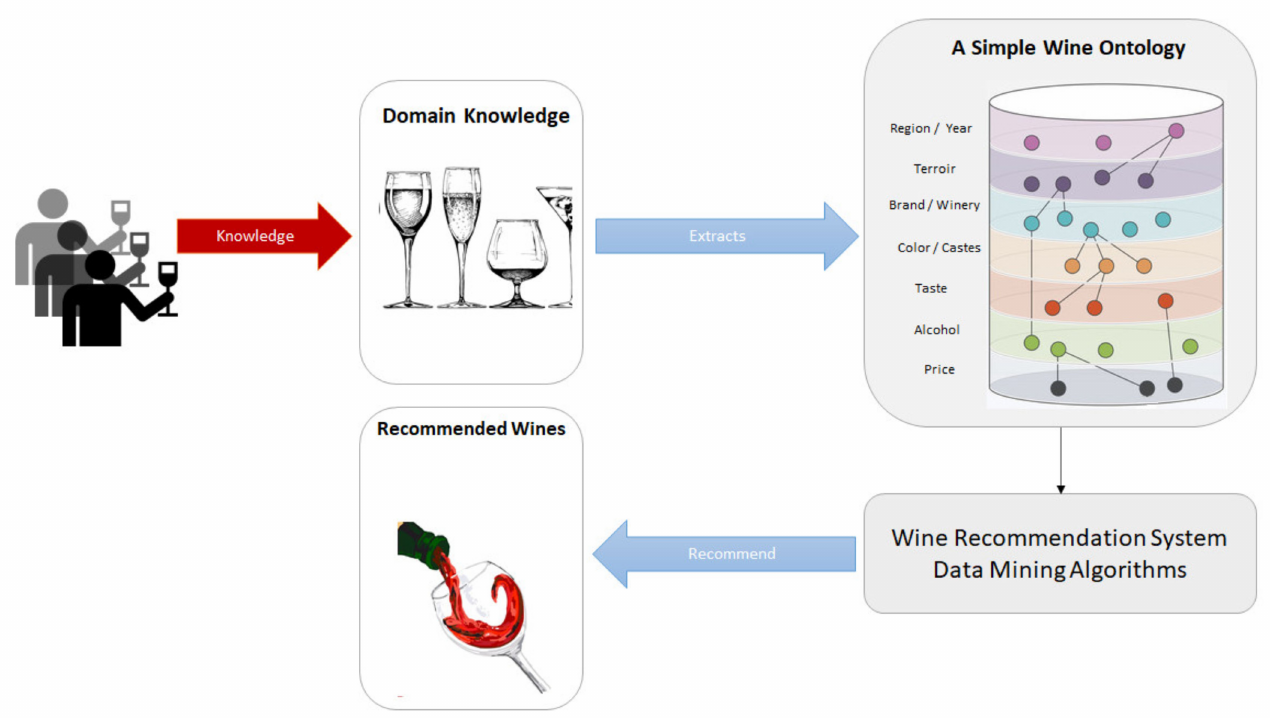
Figure 2. Research model overview of this